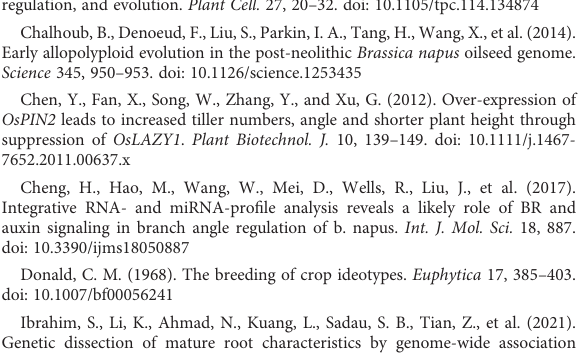
SUPPLEMENTARY FIGURE 1 Schematic diagram of BA and BD trait examination. SUPPLEMENTARY FIGURE 2 The qRT-PCR validation of four random DEGs. The horizontal axes represent eight samples of transcriptomic analysis. The blue and orange vertical axes represent the FPKM values and relative expression levels,